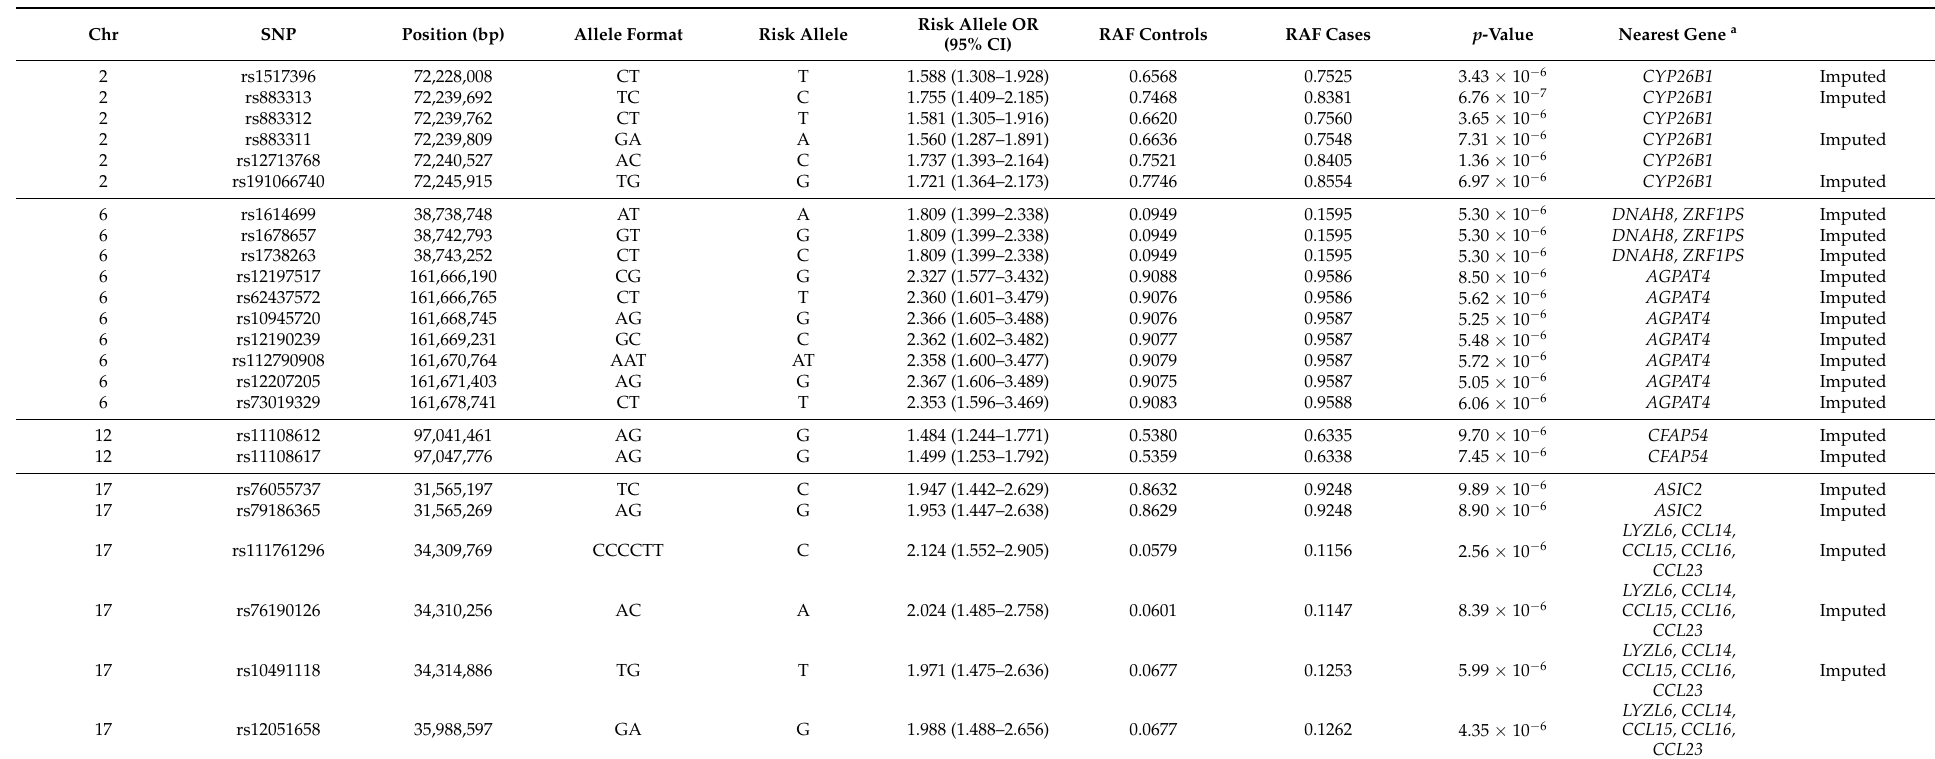
Table 2. Top SNPs associated with hand OA in the